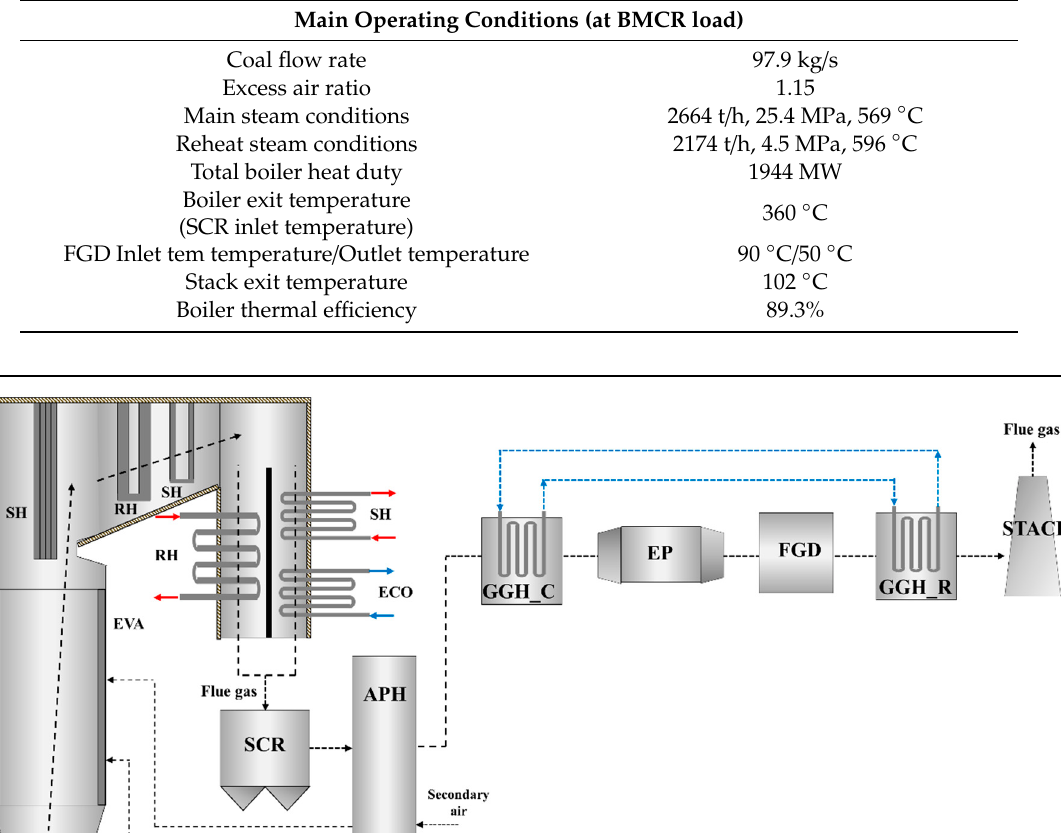
Table 2. Main operating conditions of the target plant at boiler maximum continuous rating (BMCR) load conditions.